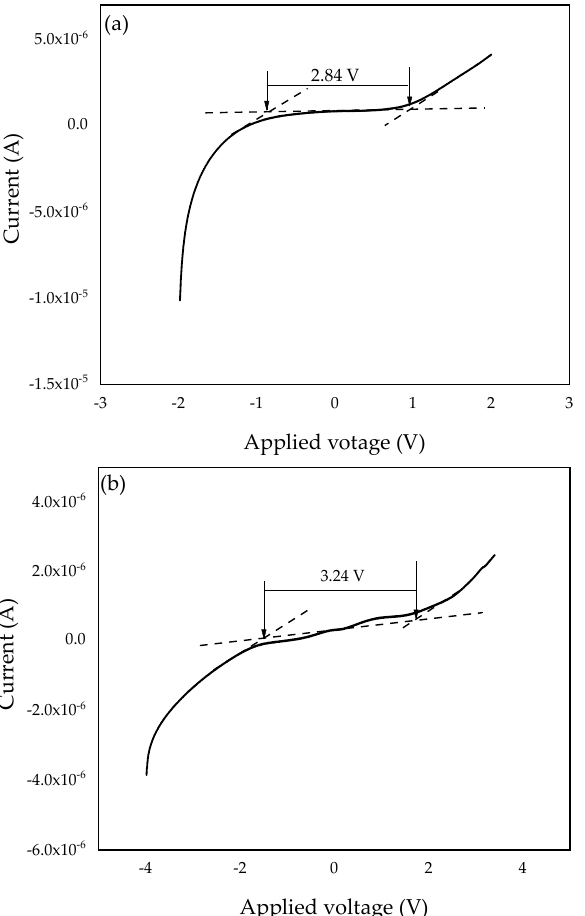
Figure 11. Linear sweep voltammetry (LSV) plots of the ( a ) PZ0 and ( b ) PZ10 composite SPE sam- ples.